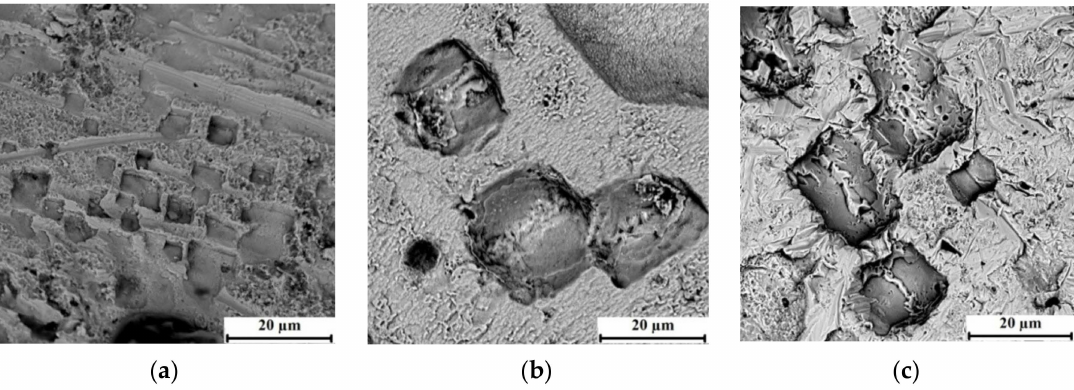
Figure 6. The processed surface of the copper layer of bimetallic material ( × 4000): ( a ) graphite ET, ( b ) copper ET, ( c ) composite